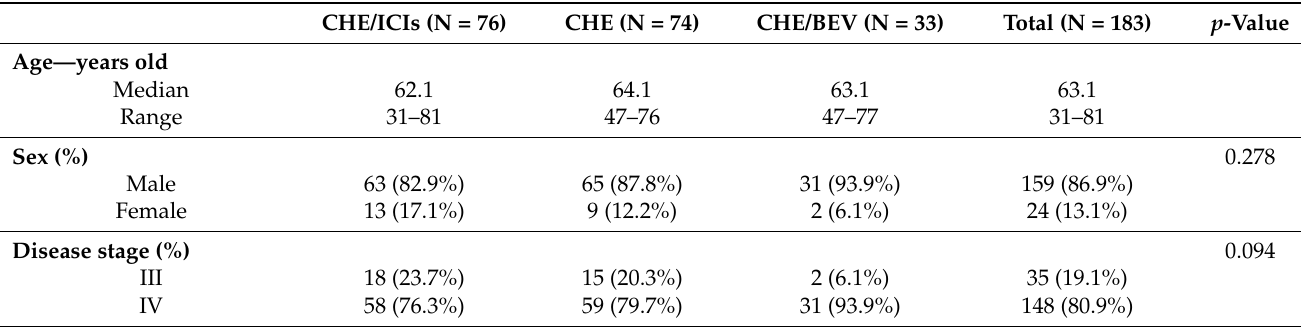
Table 1. Baseline patient